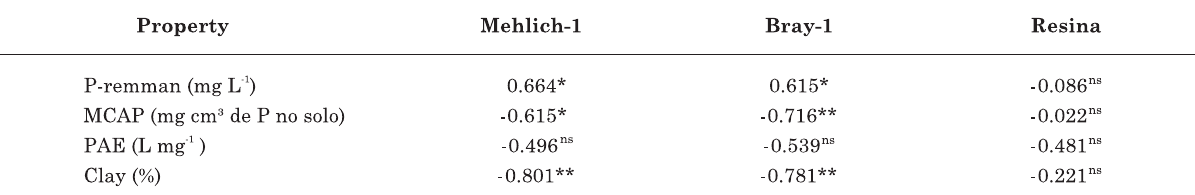
Table 12. Simple linear correlation coefficients between the mean P levels extracted by Mehlich-1, Bray-1 and resin, after adjusting different values of pH to 6.5, and properties that reflect the capacity factor of phosphorus